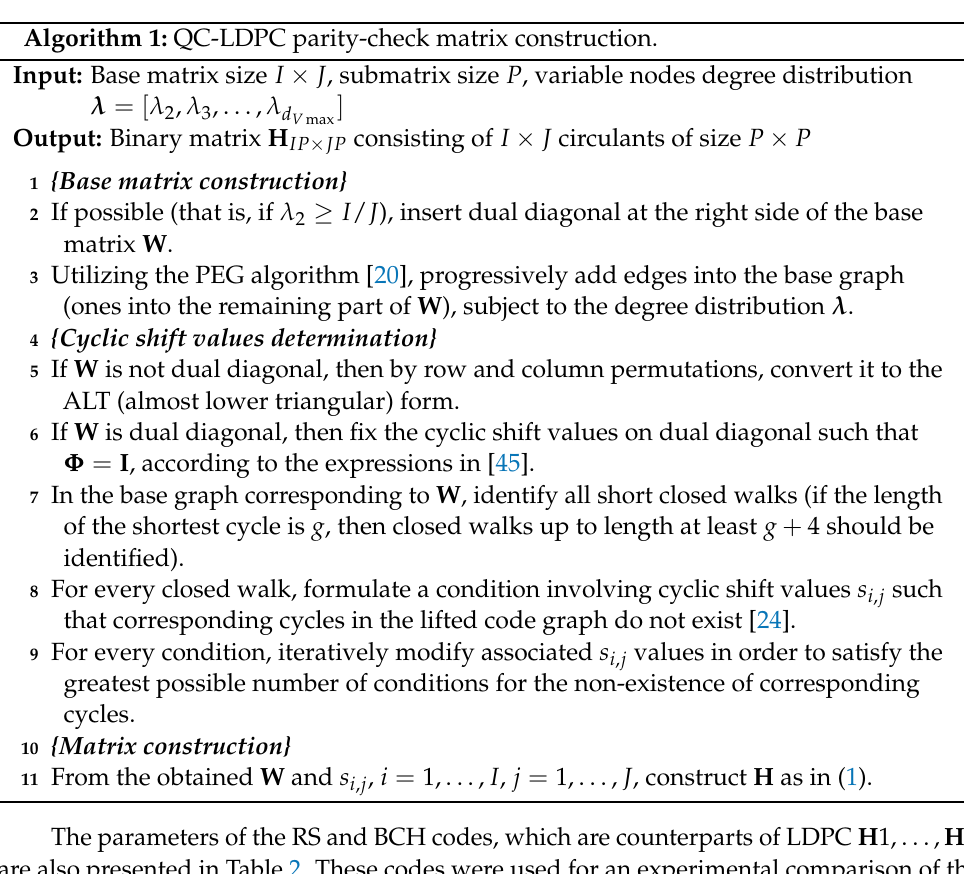
Algorithm 1: QC-LDPC parity-check matrix construction.